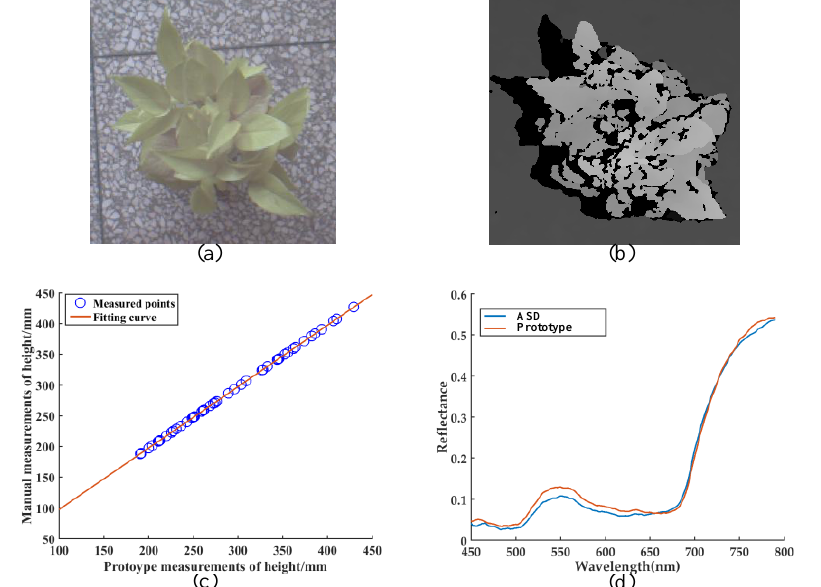
Fig. 7. Experiment results. (a) Image of left camera; (b) Disparity map; (c) Result of linear regression analyses between manual measurements and prototype measurement; (d) Spectral Data of ASD and Integrated